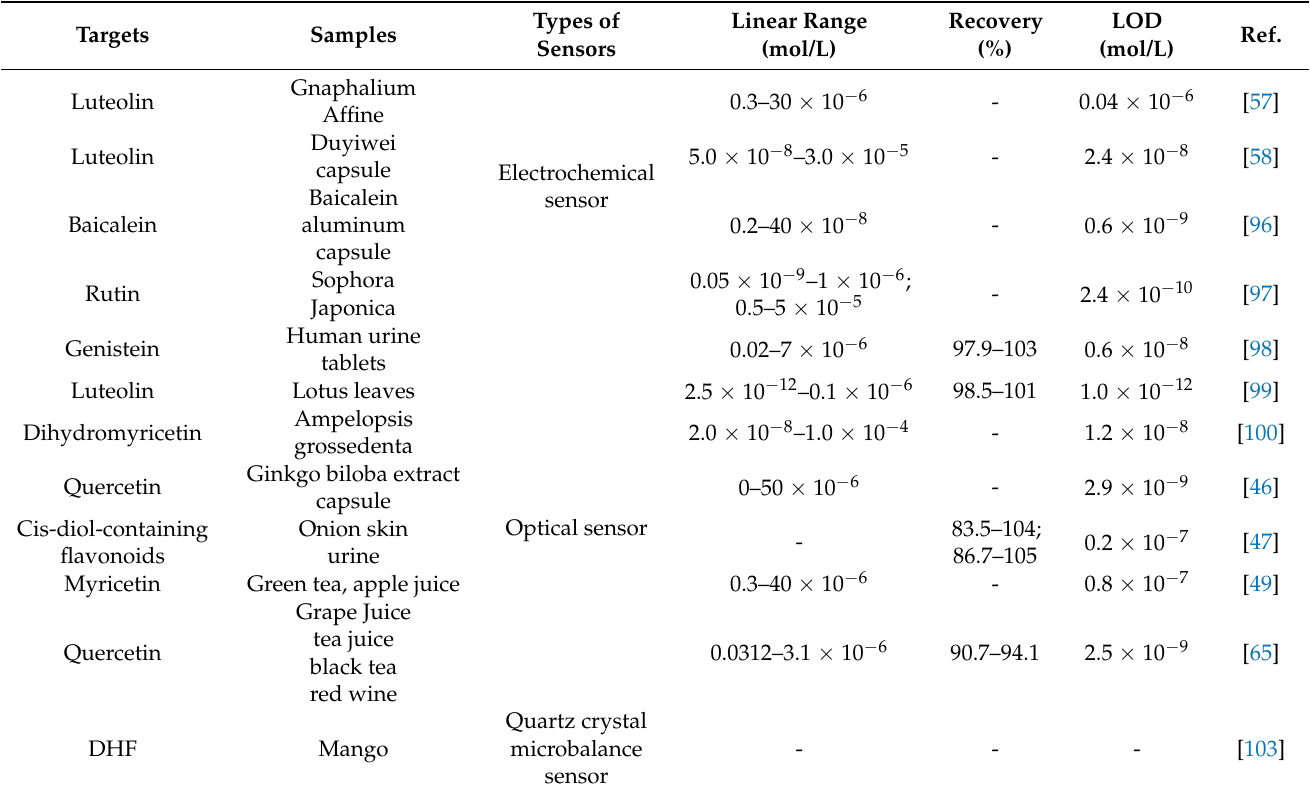
Table 3. MIP-based sensor for detecting